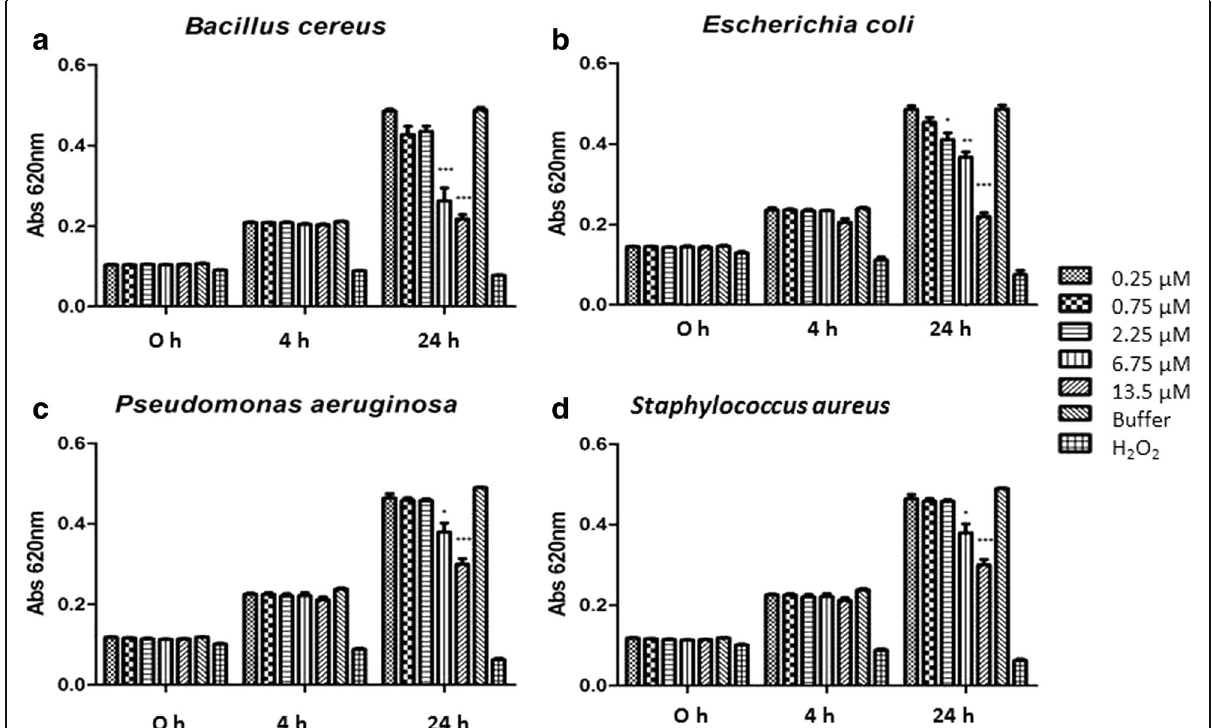
Fig. 2 Effects of jaburetox on bacteria. Bacterial multiplication was evaluated by absorbance at 620 nm at time zero, and 4 and 24 h after incubation in the presence of different concentrations of JBTX. a Bacillus cereus ; b Escherichia coli ; c Pseudomonas aeruginosa ; d Staphylococcus aureus . Growth in the presence of buffer (Tris HCl 10 mM pH 7.0) or H 2 O 2 was considered as negative and positive control, respectively. Each graph represents three independent experiments in triplicates for each condition. Results are mean ± SD. Asterisks (*) indicate statistical differences ( p values ≤ 0.05, Tukey test). Copyright by I. A. Terra [33]. Reprinted with